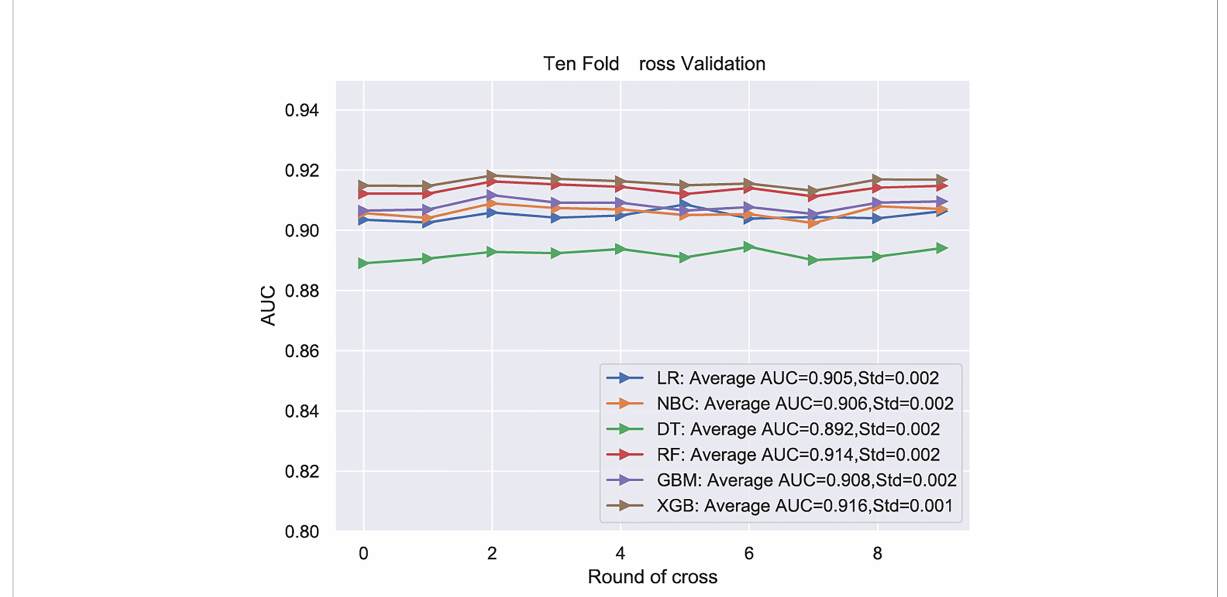
FIGURE 2 .Among all ML-ed models, the XGB model showed the best predictive performance. LR, Logistic regression; NBC, Naive Bayes Classi fi er; DT, Decision tree; RF, Random Forest; GBM, Gradient boosting machine; XGB, Extreme gradient boosting; Std, Standard Deviation.